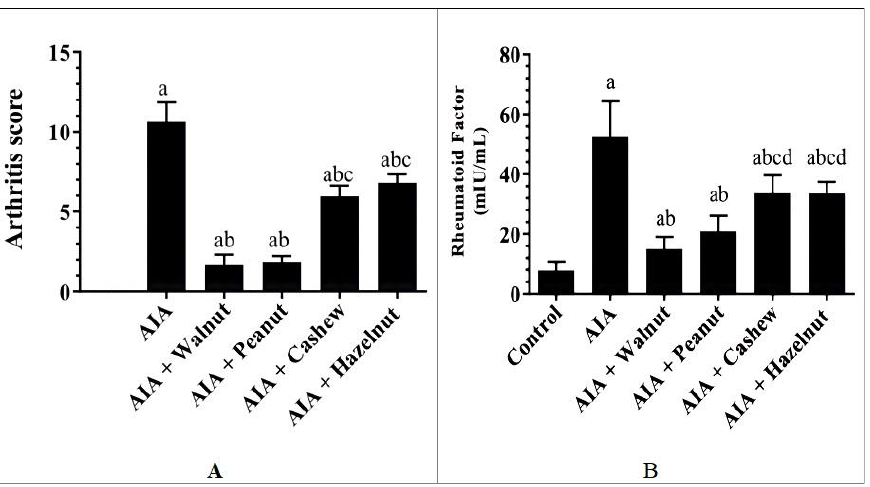
Figure 4. Effect of different nuts ’ oil on arthritis score ( A ) and serum levels of rheumatoid factors ( B ) in adjuvant-induced arthritis (AIA) rats. The arthritis score was calculated on a scale of 0 – 4/paw (an overall of 16 for the four paws). Accordingly, score 0.0: swelling or redness; score 1: redness or swelling in one paw or digit (one joint); score 2: redness and swelling in 2 digits or joints; score 3: swelling and redness in more than two digits or joints; and score 4: swelling and redness in all joints or digits or the entire paw. Model: One-way analysis of variance (ANOVA) with a statistical significance assumed at p ≤ 0.05 followed by Tukey’s HSD post hoc test for statistically significant p -value. Data are presented as mean ± SD for n = 5 rats/groups. a: Different from the control rats. b: Significantly different from the adjuvant-induced arthritis model rats (AIA). c: Significantly different from AIA + walnut oil. d: Significantly different from AIA + peanut oil.